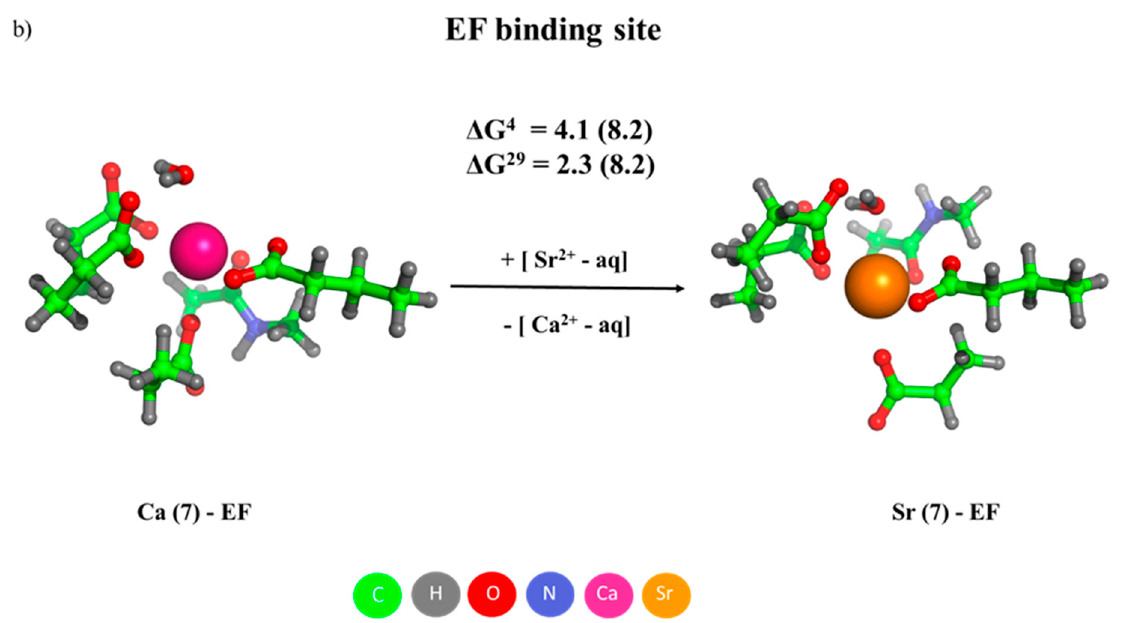
Figure 7. M06-2X/6-311++G** optimized structures of Ca 2+ /Sr 2+ -loaded CD ( a ) and EF ( b ) sites of parvalbumin, and free energies of Ca 2+ → Sr 2+ exchange (in kcal/mol). The free energies evaluated for rigid Ca 2+ -binding sites are given in parentheses. ∆ G 4 and ∆ G 29 refer to cation exchange free energies in an environment characterized by an effective dielectric constant of 4 and 29, respectively. Positive free energies imply Ca 2+ ‐ selective binding sites. Reprinted from Ref. [27]. Copyright 2021 MDPI.